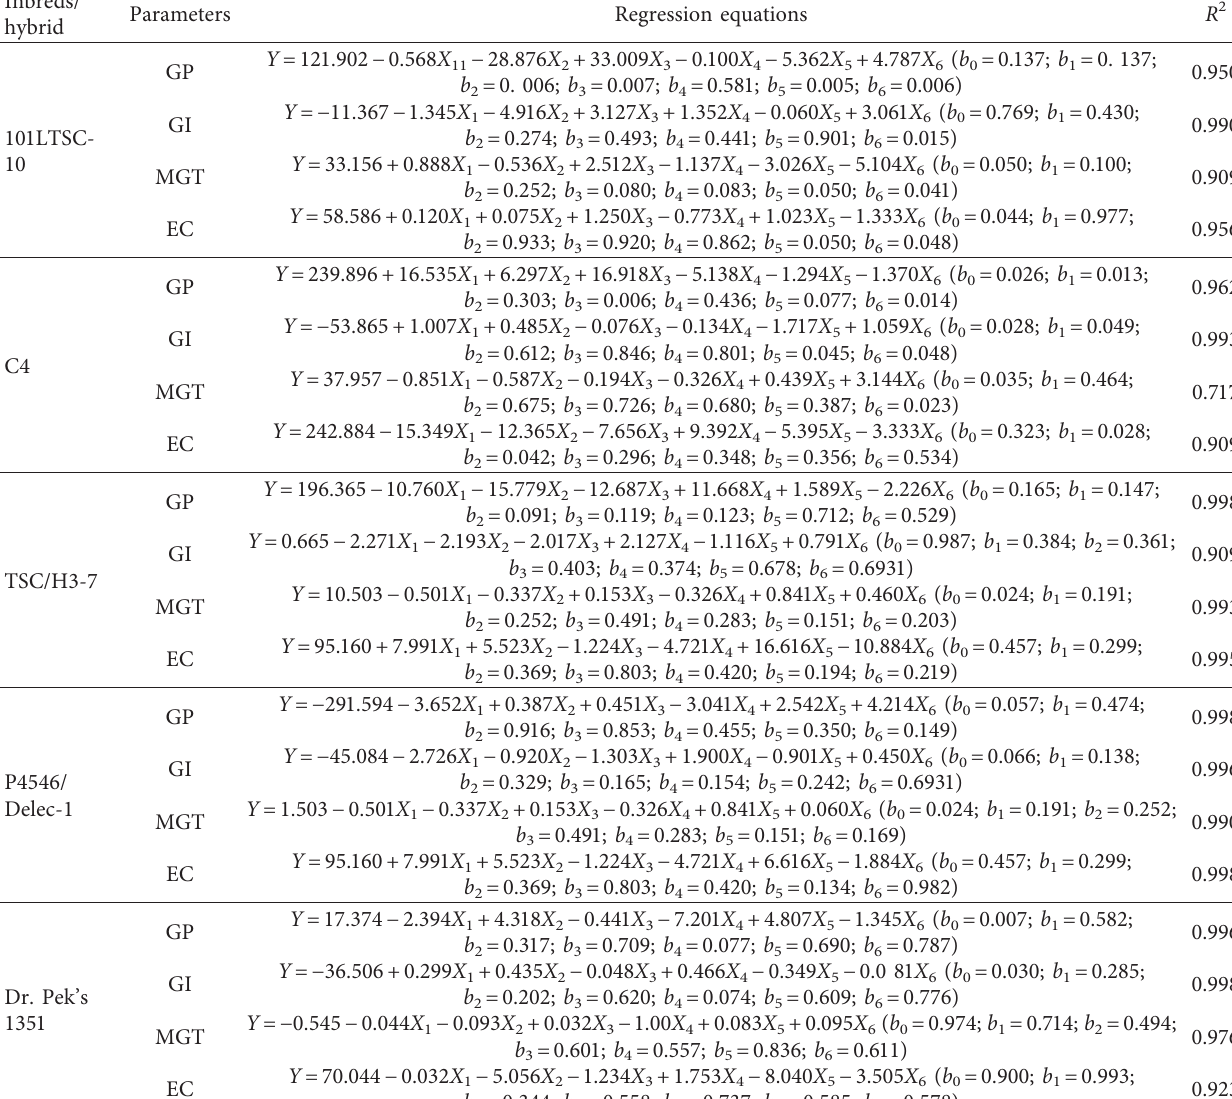
Table 2: Regression equations between seed quality and carbohydrate characters during seed developments of sweet corn.